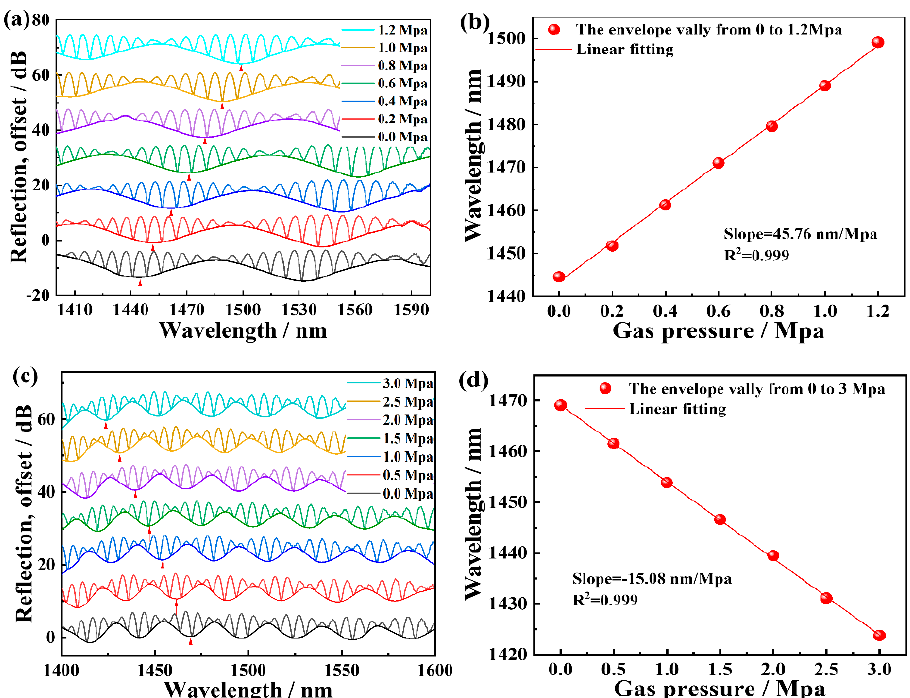
Figure 7. Response of paralleled FPI sensor to pressure. Prototype 1: ( a ) Reflection spectrum under different pressure; ( b ) linear fitting. Prototype 2: ( c ) The reflection spectrum under different pressure; ( d ) linear fitting.